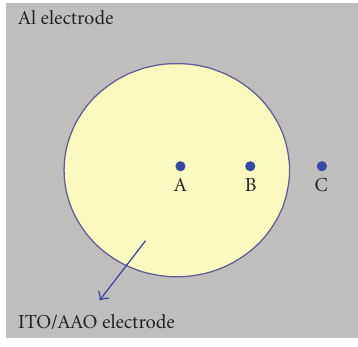
Figure 4: Resistances of ITO film annealed at di ff erent tempera- tures.